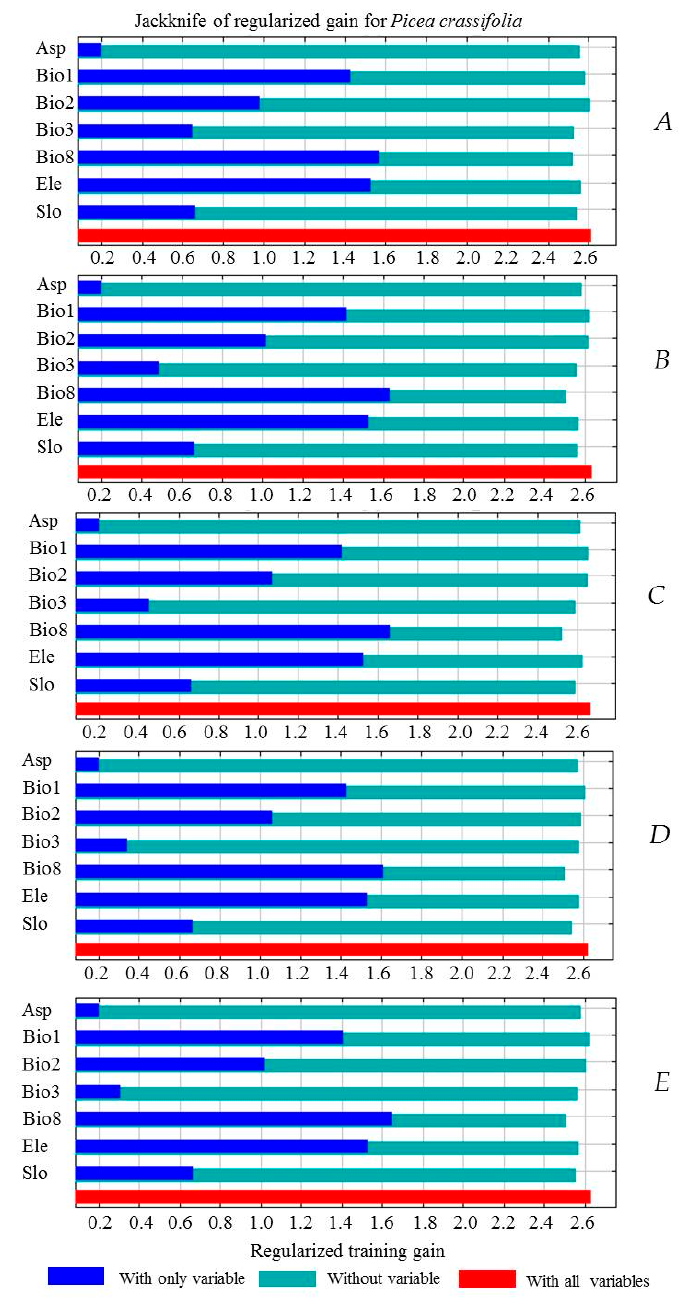
Figure 2. ( A ) The results of the jackknife test of variables’ contribution in modeling Qinghai spruce’s habitat distribution under current climate condition; ( B ) The results of the jackknife test of variables’ contribution in modeling Qinghai spruce’s habitat distribution under climate change scenarios RCP2.6; ( C ) The results of the jackknife test of variables’ contribution in modeling Qinghai spruce’s habitat distribution under climate change scenarios RCP4.5; ( D ) The results of the jackknife test of variables’ contribution in modeling Qinghai spruce’s habitat distribution under climate change scenarios RCP6.0; ( E ) The results of the jackknife test of variables’ contribution in modeling Qinghai spruce’s habitat distribution under climate change scenarios RCP8.5.(The regularized training gain describes how much better the Maxent distribution fits the presence data compared to a uniform distribution. The dark blue bars indicate the gain from using each variable in isolation, the light blue bars indicate the gain lost by removing the single variable from the full model, and the red bar indicates the gain using all of the variables)., 34% in, 33.9% in RCP4.5, 33.8% in RCP6.0, and 30.5% in RCP8.5.